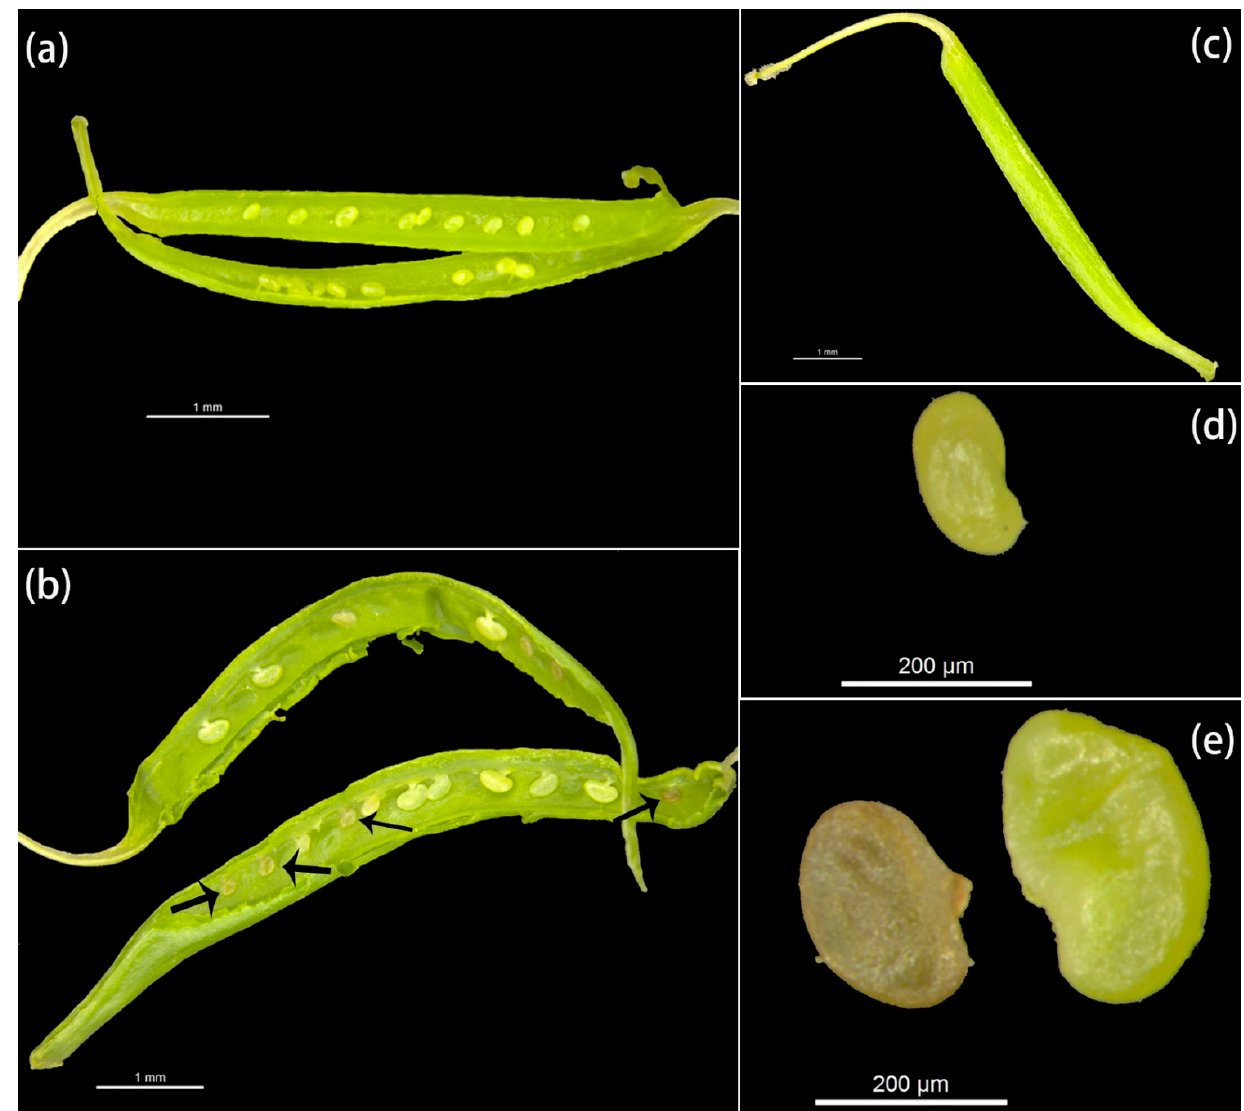
Figure 2. Ovaries and immature zygotic embryos at 7 days after pollination in ( a , c , d ) 2016 and ( b , e ) 2017.